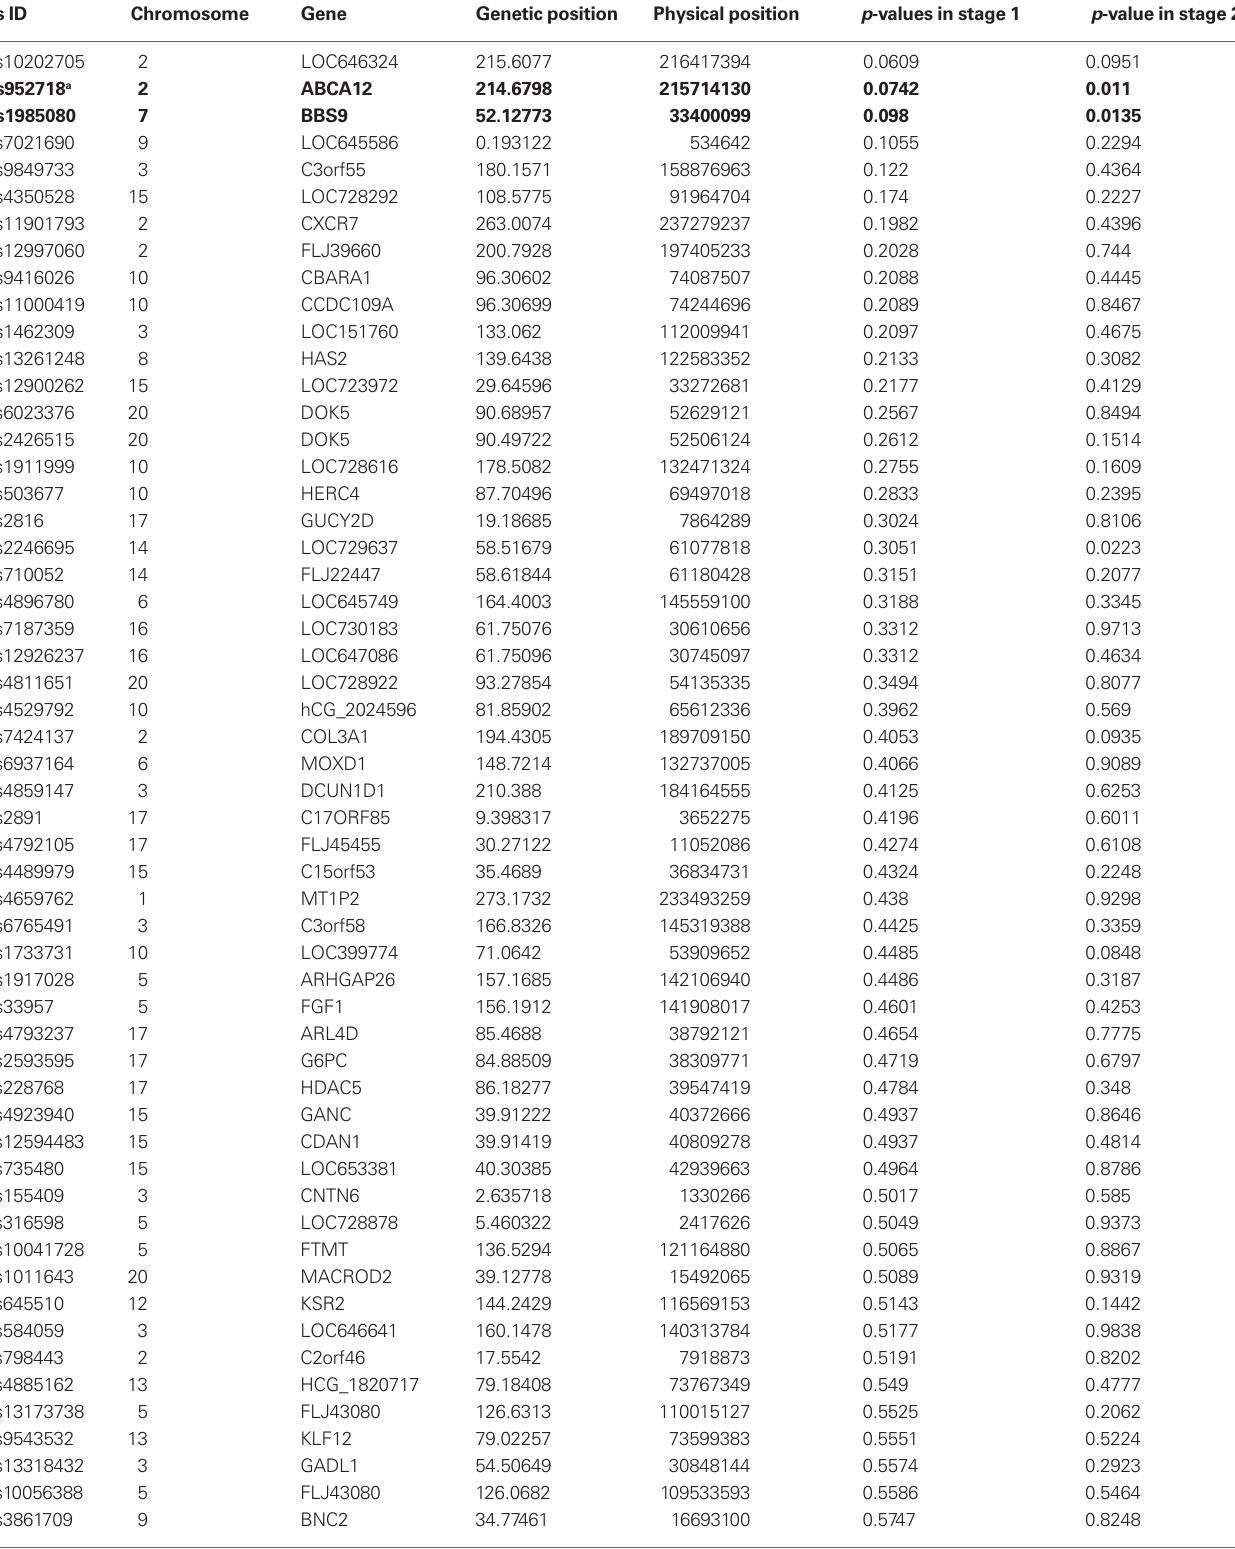
Table A3 | information on 108 ancestry informative markers and the p -values of association with height by the two-stage